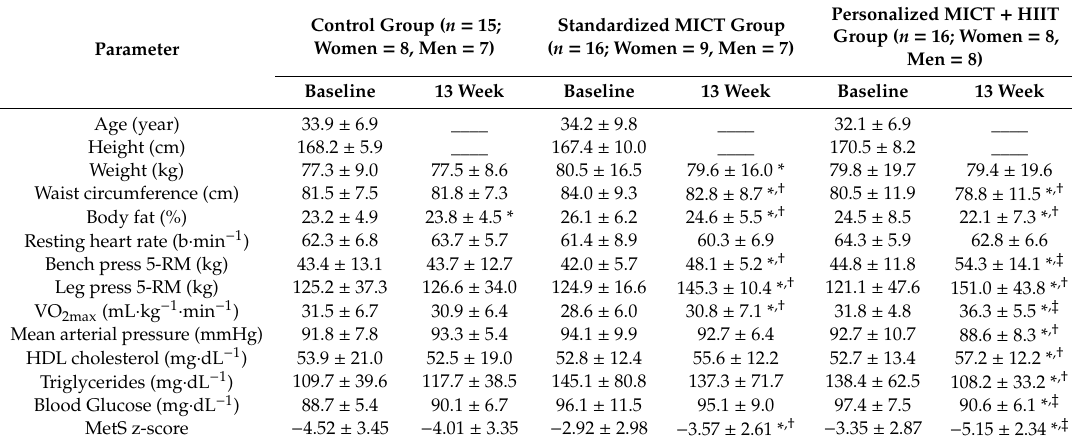
Table 1. Physical and physiological characteristics at baseline and 13 weeks for control, standardized MICT, and personalized MICT + HIIT groups. (Values are mean ±